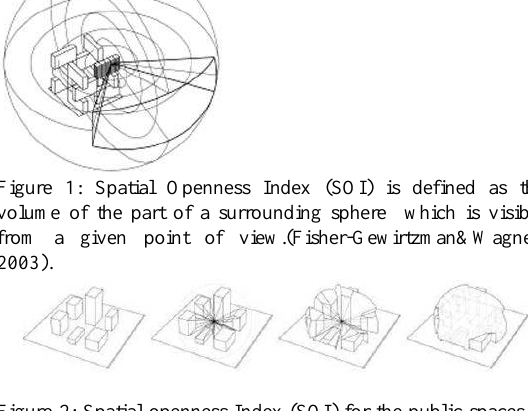
Figure 2: Spatial openness Index (SOI) for the public spaces is defined as the potential view captured from the viewpoint positioned between the buildings. The SOI is defined as the measured volume of space, which is visible from the indicated point of view.(Fisher-Gewirtzman et al. 2005).